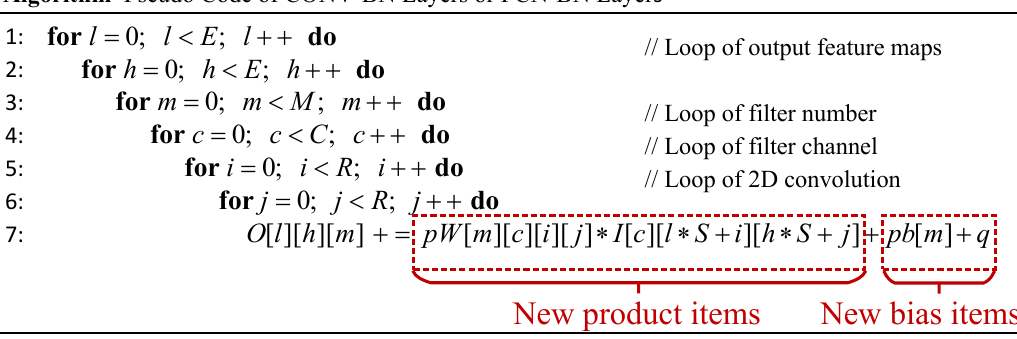
Figure 5. Pseudo code of combination